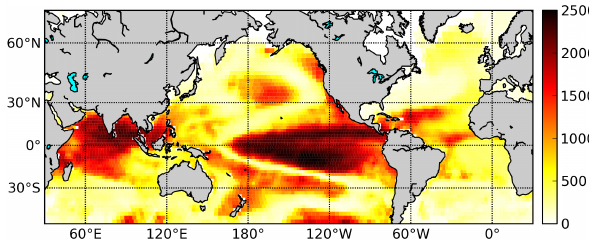
Fig. 1. Degree centrality, as defined by Eq. (3), of the nodes of the Fig. 1: Degree centrality, as defined by Eq. (3), of the nodes of the H-SST network. A threshold H-SST network. A threshold τ = 0 . 4 was used to construct the net- τ =0 . 4 was used to construct the network giving an edge density ρ =0 . 14 . work giving an edge density ρ = 0 . 14.